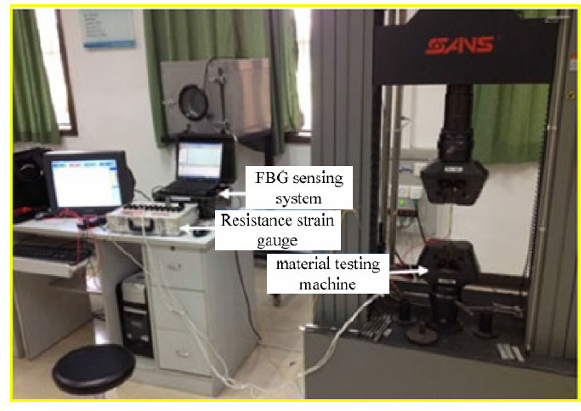
Fig. 8 Monitoring system of tensile test.